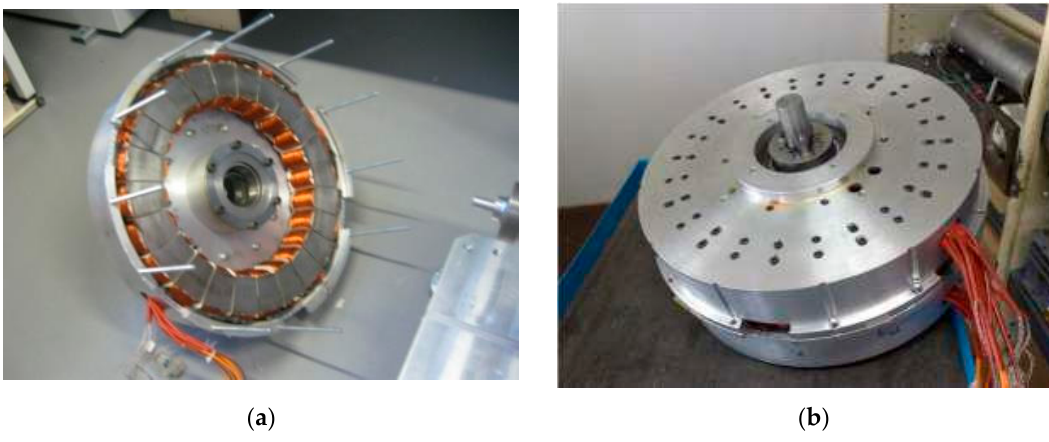
Figure 7. Axial field surface mounted permanent magnet synchronous machine prototype designed at GREAH: ( a ) assembled stator view; ( b ) the full machine assembly.